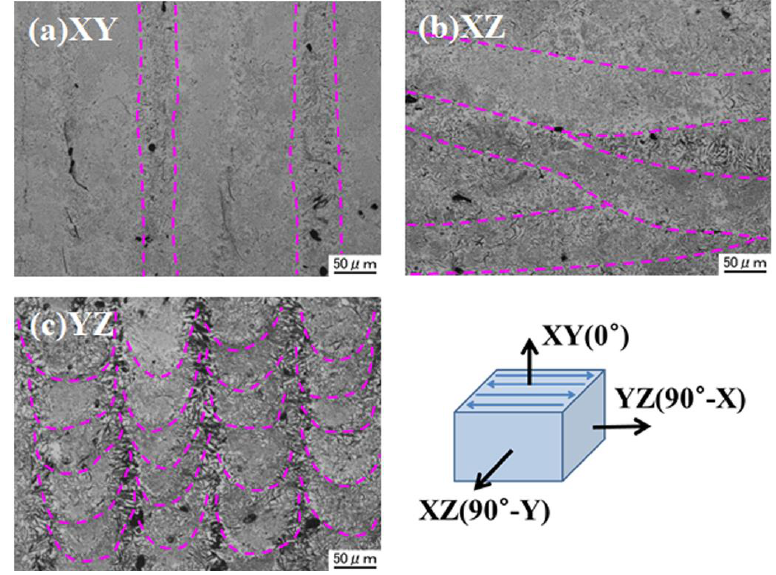
Figure 18. OM images of the ( a ) XY, ( b ) XZ, and ( c ) YZ cross sections of the Cu plated C/Al SLM composite fabricated with XD scanning pattern. Broken lines indicate solidification boundaries of beads.